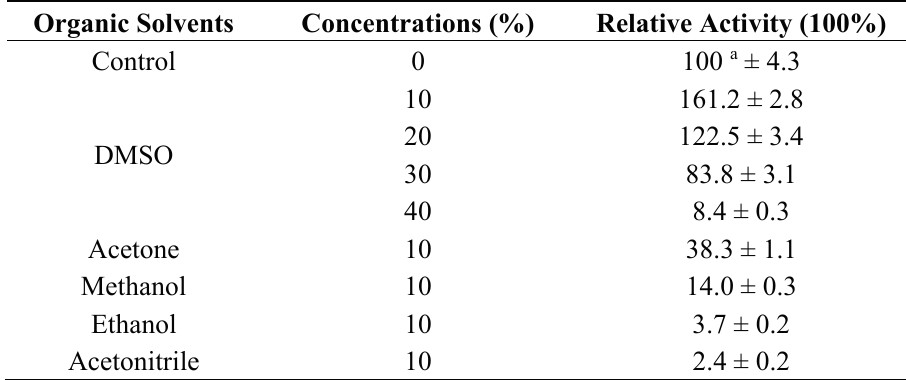
Table 3. Effect of organic solvents on the activity of ReBDH.